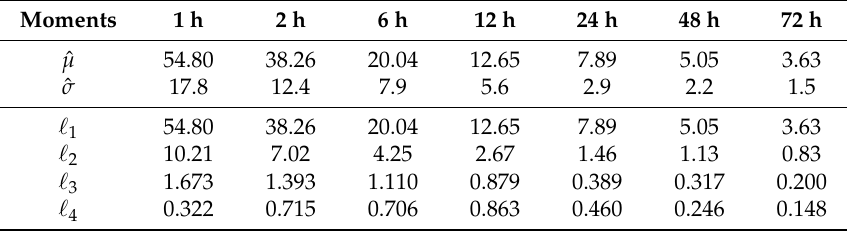
Table 2. Sample moments (in mm/h) of rainfall intensity data.